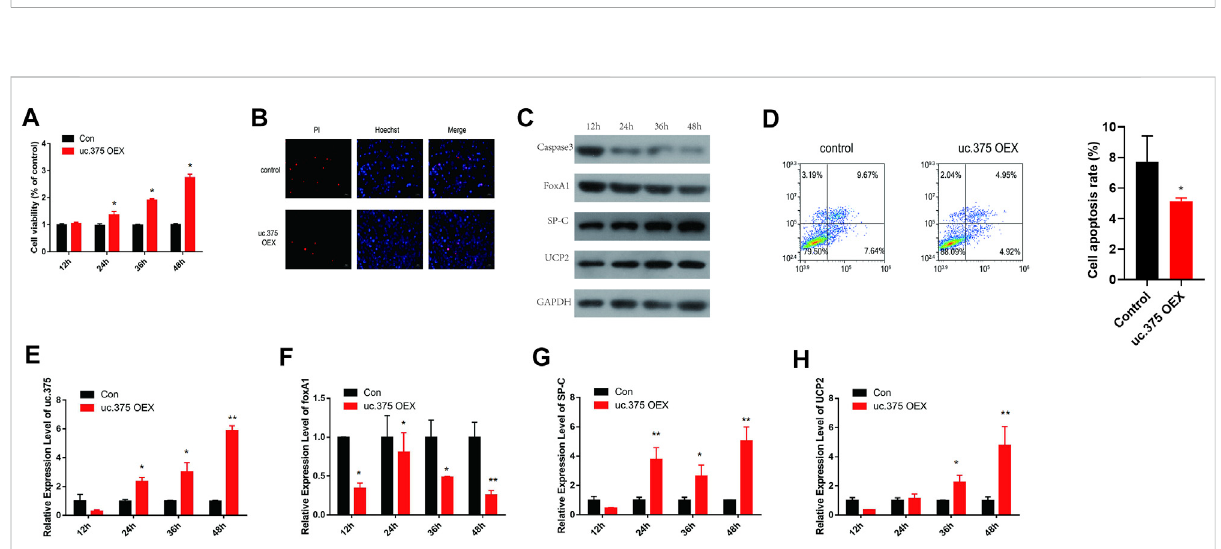
FIGURE 3 The effect of uc.375 overexpression on the function of MLE 12 cells. (A) The proliferation activity of MLE 12 cells was detected by CCK-8 assay. (B) The cell apoptosis was determined by Hoechst/PI staining in MLE 12 cells. (C) The protein levels of caspase3, FoxA1, SP-C and UCP2 were investigated by western blot in MLE 12 cells. (D) The cell apoptosis was determined using low cytometry assay in MLE 12 cells. (E-H) The relative mRNA expression levels of uc.375, FoxA1, SP-C and UCP2 were detected by qRT-PCR in MLE 12 cells. * p < 0.05, ** p < 0.01 vs.